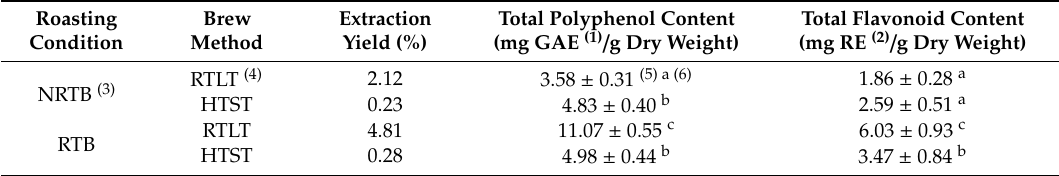
Table 1. Extraction yield, and total polyphenol and flavonoid contents of TB